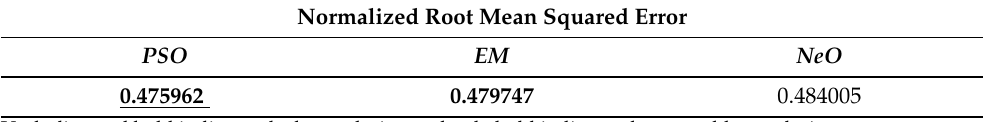
Table 4. Training error for gas turbine NO x emission